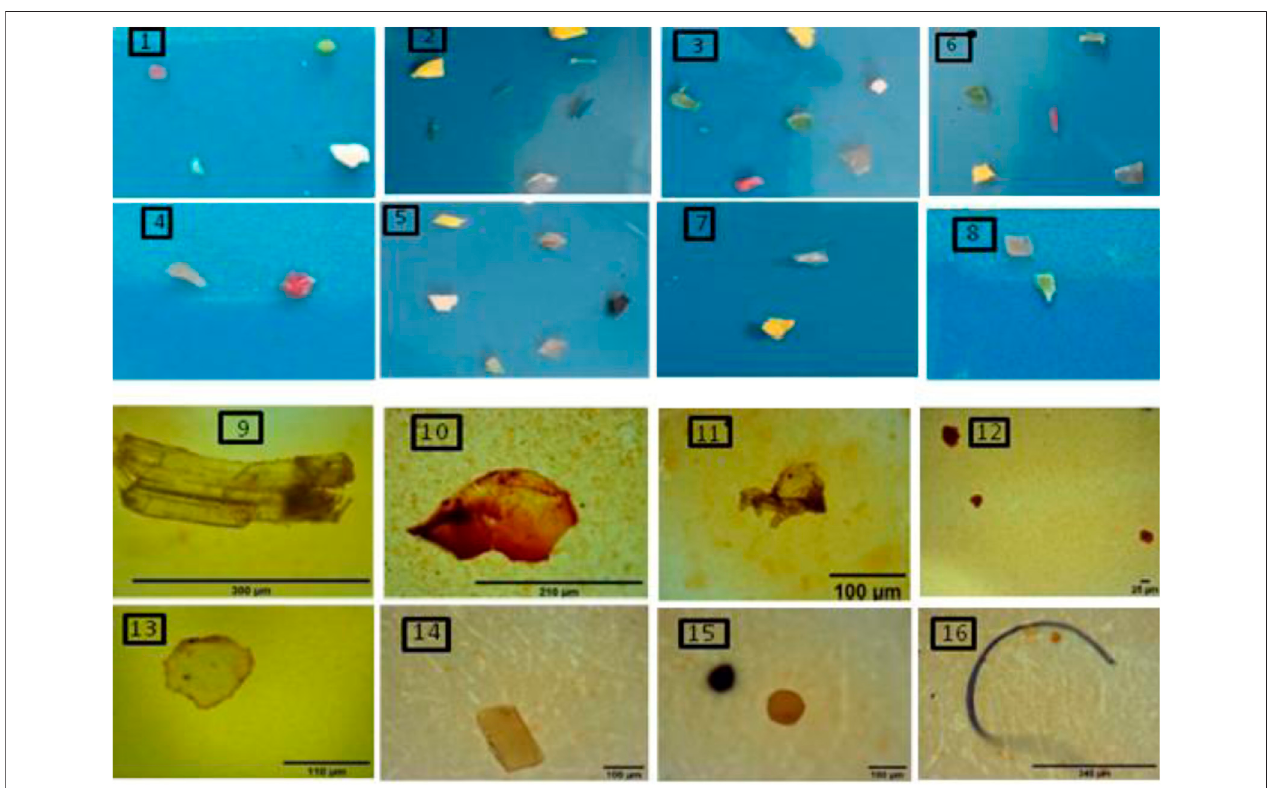
FIGURE 2 | Pictorial representation of some of the identi fi ed MPs in different sizes, shapes, and colors in sediment and agglomerated sewage water samples with greater than 0.5 mm (1 – 8) and less than 0.5 mm (9 – 16).